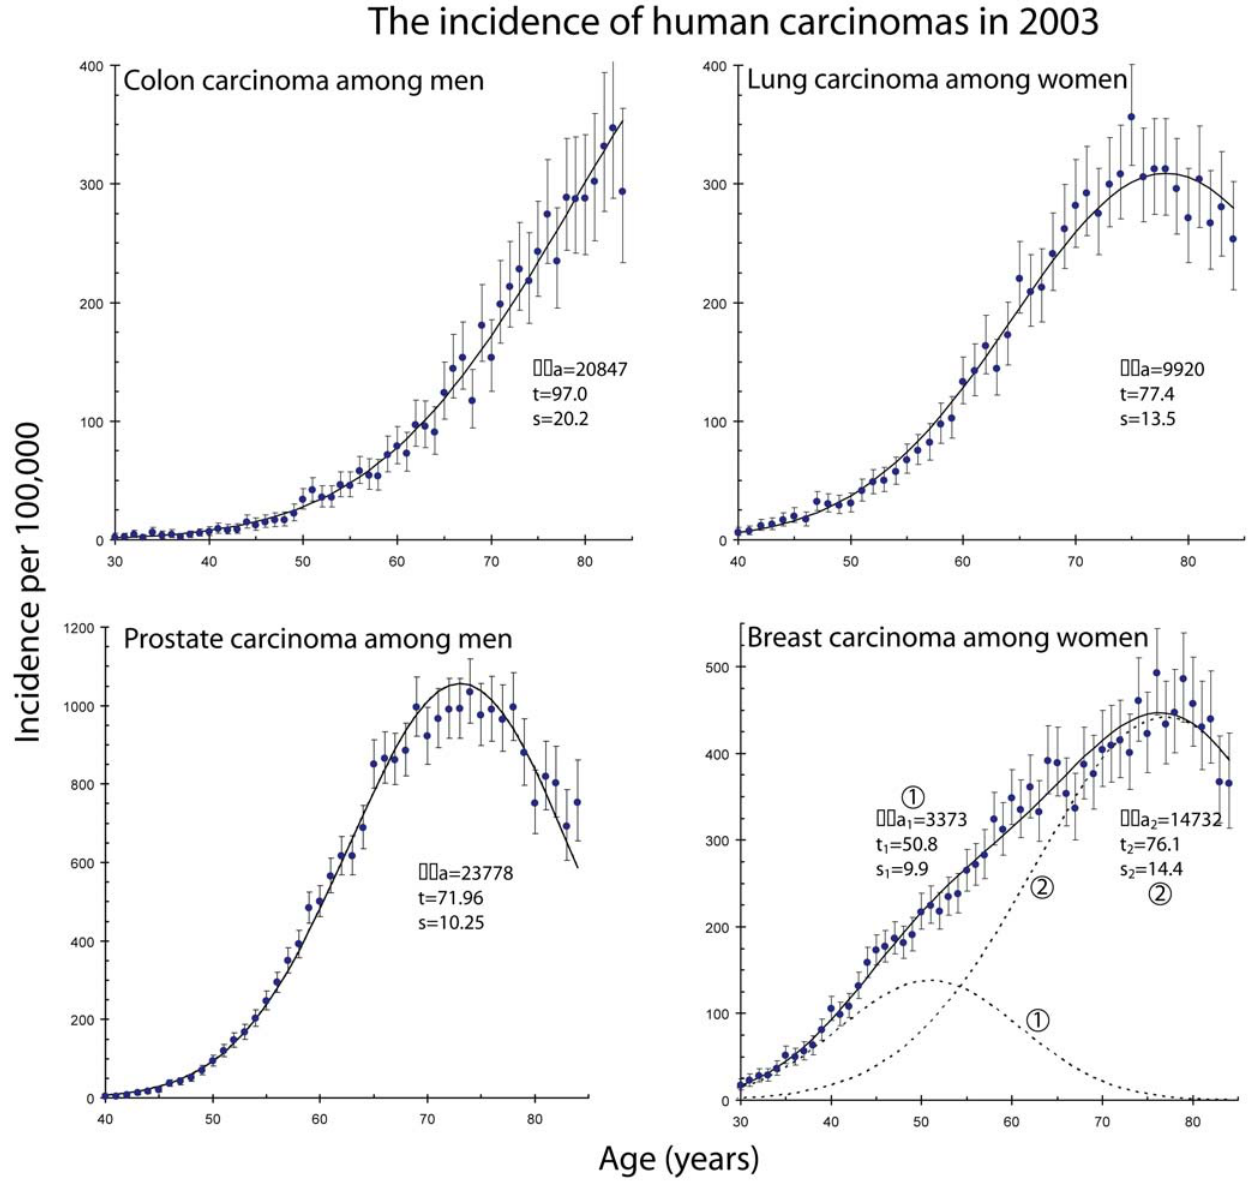
confidence intervals by error bars. A solid line represents the hypothesis, (Equation 3 for colon, lung, and prostate carcinomas and Equation 4 breast carcinomas) and the parameters for the model are indicated on the